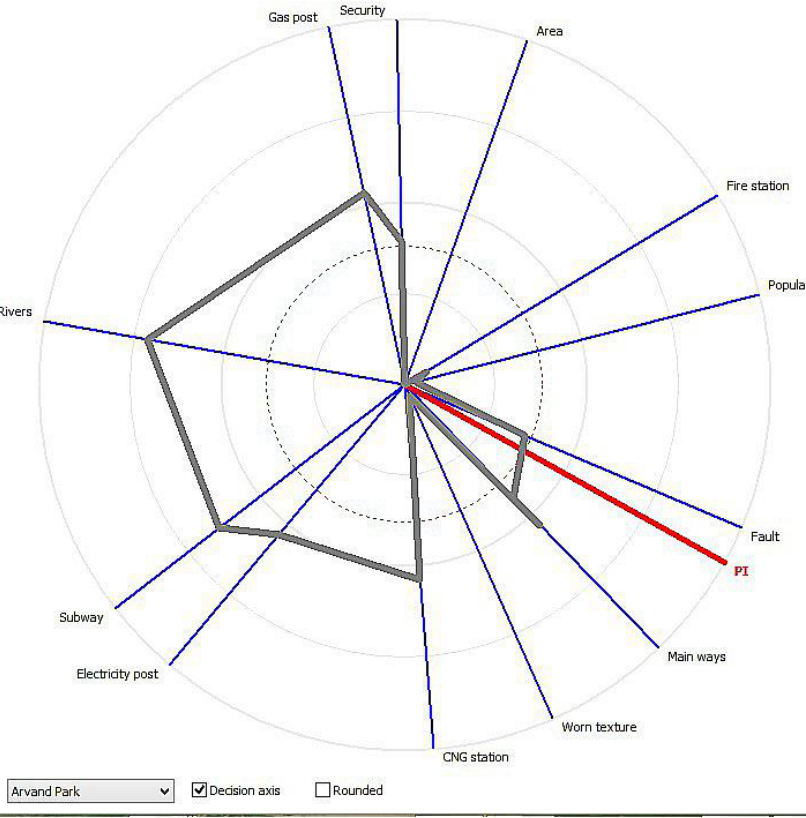
Fig. 7. GAIA web option Arvand Park.